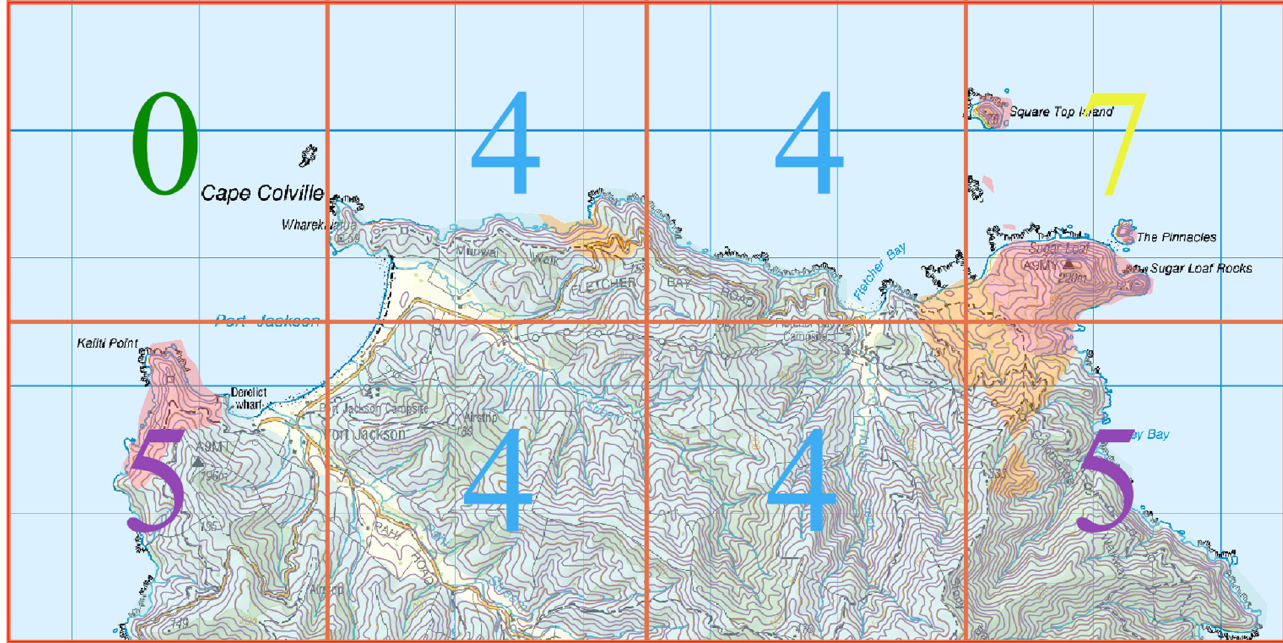
Figure 7. The results of the assessment of geodiversity for every zone of the Port Jackson, Fletcher Bay, and Port Charles districts (Coromandel Peninsula). Geological polygon vector model, contour lines, and topographic map are presented as background.